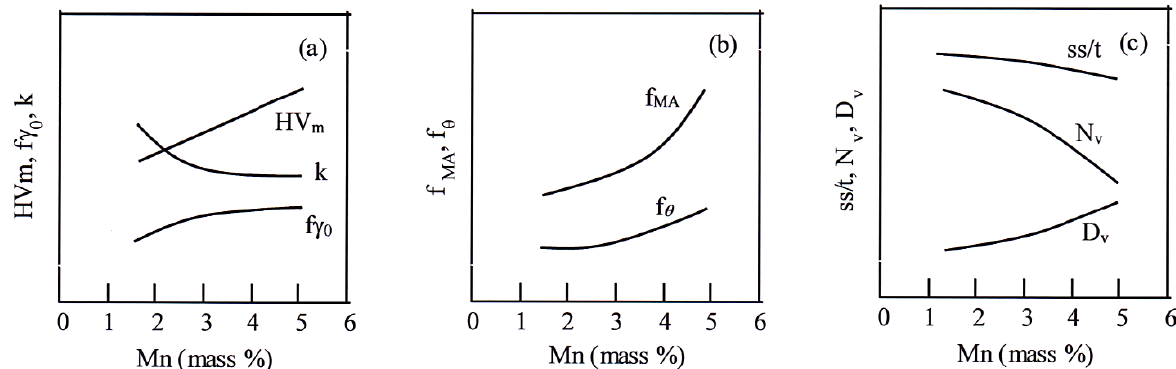
Figure 12. Relationships between TS × TEl and TS × UEl and ( a ) initial volume fraction ( f γ 0 ) and ( b ) strain-induced transformation factor ( k ) of retained austenite in the 1.5Mn ( ◇ ), 3Mn ( ▲ ), and 5Mn (●) steels . The IT temperatures are between M s and M f − 100  C.